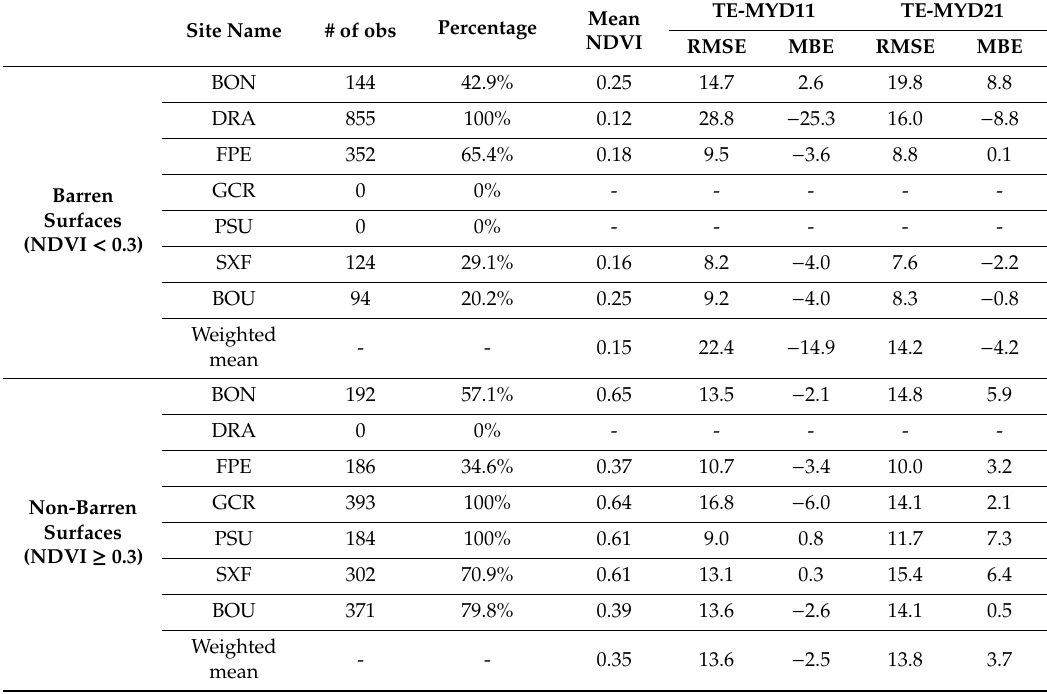
temperature-emissivity methods (W / m 2